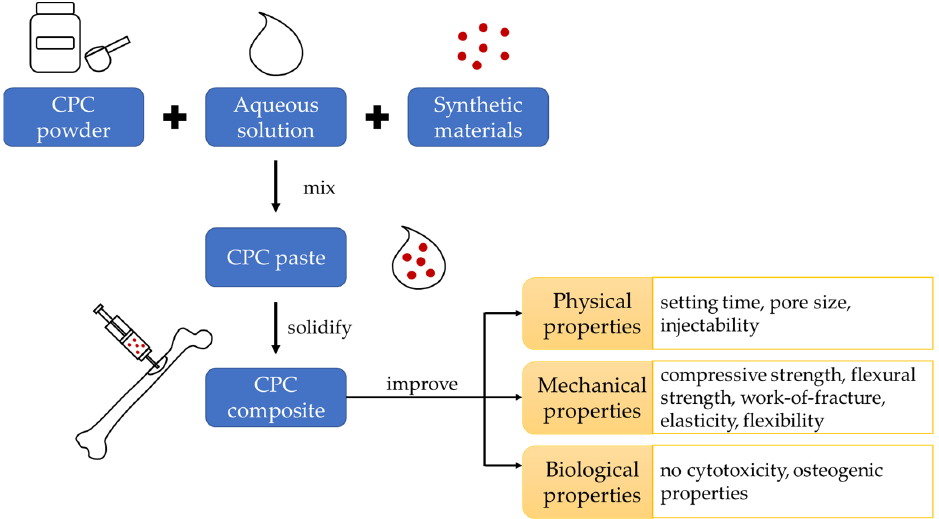
Figure 1. Conceptual framework of the review.